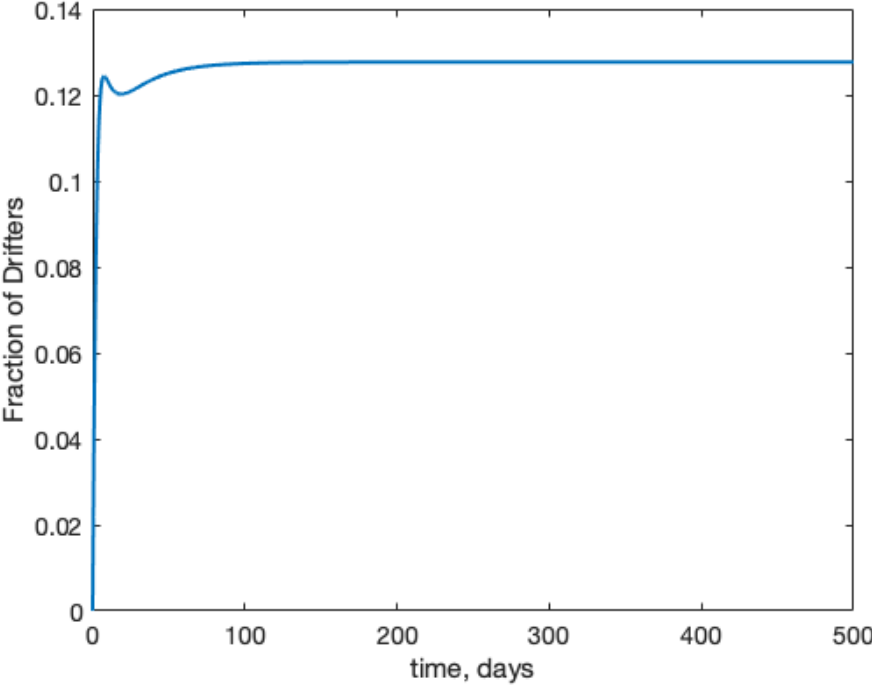
Figure 2. With the drifting rate set at 10%, we see that on average 12% of the foragers in a colony are foreign. These results are consistent with experimental findings.